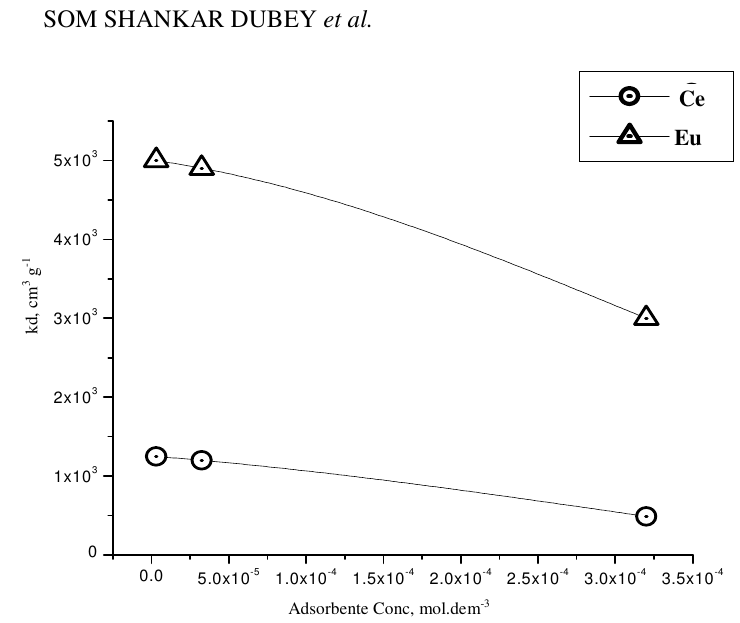
with change in adsorbate d